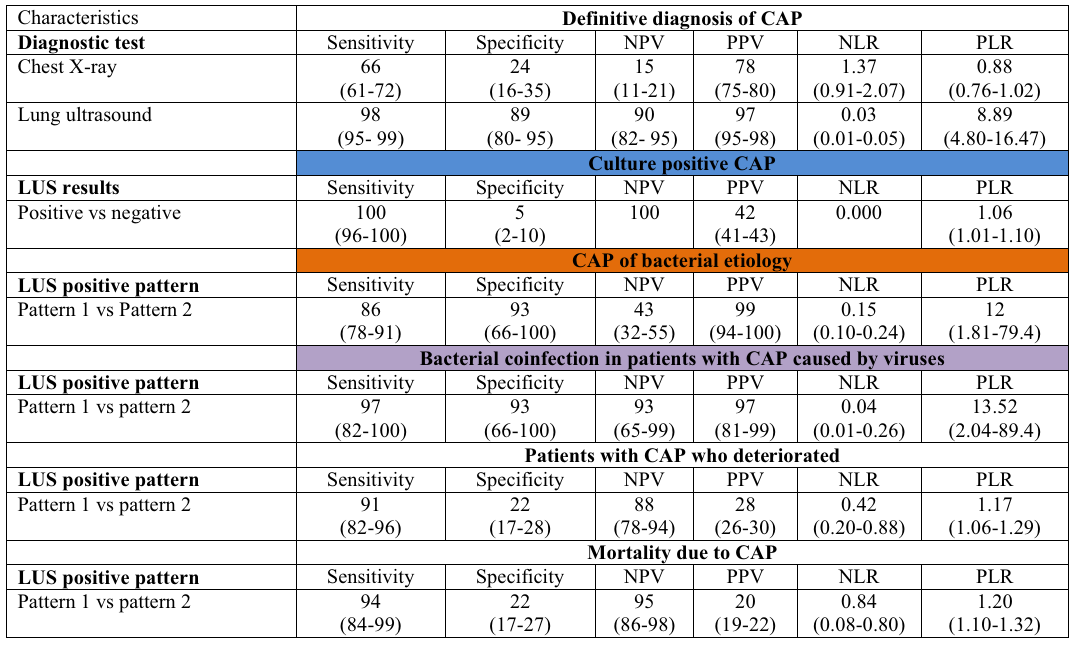
Table 2. Performance of chest X-ray and lung ultrasound for predicting the definitive diagnosis of community- acquired pneumonia (first analysis) and performance of lung ultrasound for predicting outcomes in the second analysis. CXR Chest X-Ray, LUS lung ultrasound, CAP community-acquired pneumonia, NPV negative predictive value, PPV positive predictive value, NLR negative likelihood ratio, PLR positive likelihood ratio. The color of the heading refers to the color assigned to the specific microbiological cohort of community-acquired pneumonia patients in Figure